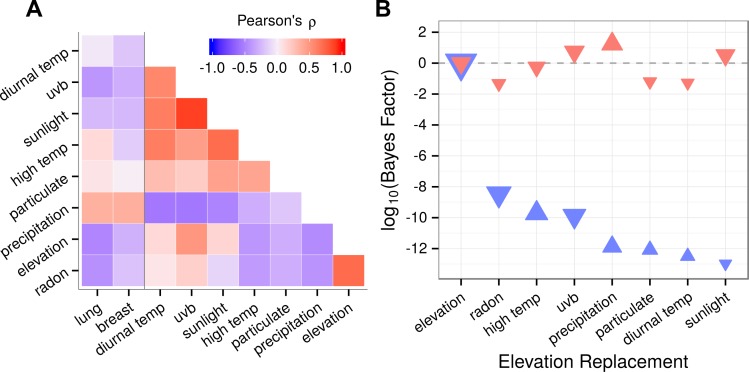
Environmental substitutes outperform elevation for breast but not lung cancer.(A) Environmental variables were strongly collinear. Correlation with elevation was high, hence many environmental variables also covaried with lung and breast cancer. (B) To test whether elevation-association with lung and breast cancer was direct or indirect, we substituted each environmental correlate in place of elevation during best subset selection for each cancer. The optimal model for each elevation-replacement was compared to the unreplaced model by approximating a Bayes factor (K) from the change in BIC. The Bayes factor indicates the odds that the replacement is superior, thus K > 1 favors the substitution while K < 1 provides evidence against. Since the elevation model was compared to itself, ΔBIC = 0 and K = 1 (log10K = 0). The standardized coefficient for each environmental predictor is represented by a triangle, where size is scaled to the magnitude and orientation indicates the sign (upwards for positive). For breast cancer (red), three substitutions increased likelihood suggesting that any association observed with elevation was indirect. For lung cancer (blue), substituting elevation produced models that were many orders of magnitude less likely, suggesting that the elevation association was direct.